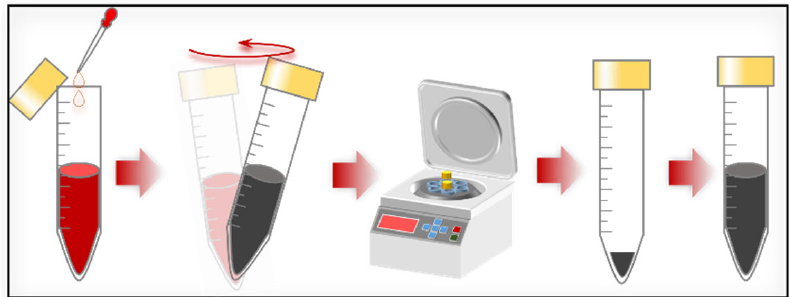
Figure 1. ( a ) Transmission electron microscopy (TEM) image of CsPbI 3 QDs. ( b ) Digital images of CsPbI 3 QDs and CsPbI 3 ‐ [SAM]C60 QD dispersions under room light (left) and excitation using an ultraviolet lamp (right) at room temperature, separately. ( c ) XRD of CsPbI 3 QDs and CsPbI 3 ‐ [SAM]C60 QDs. The black line is the PDF card of γ‐ CsPbI 3